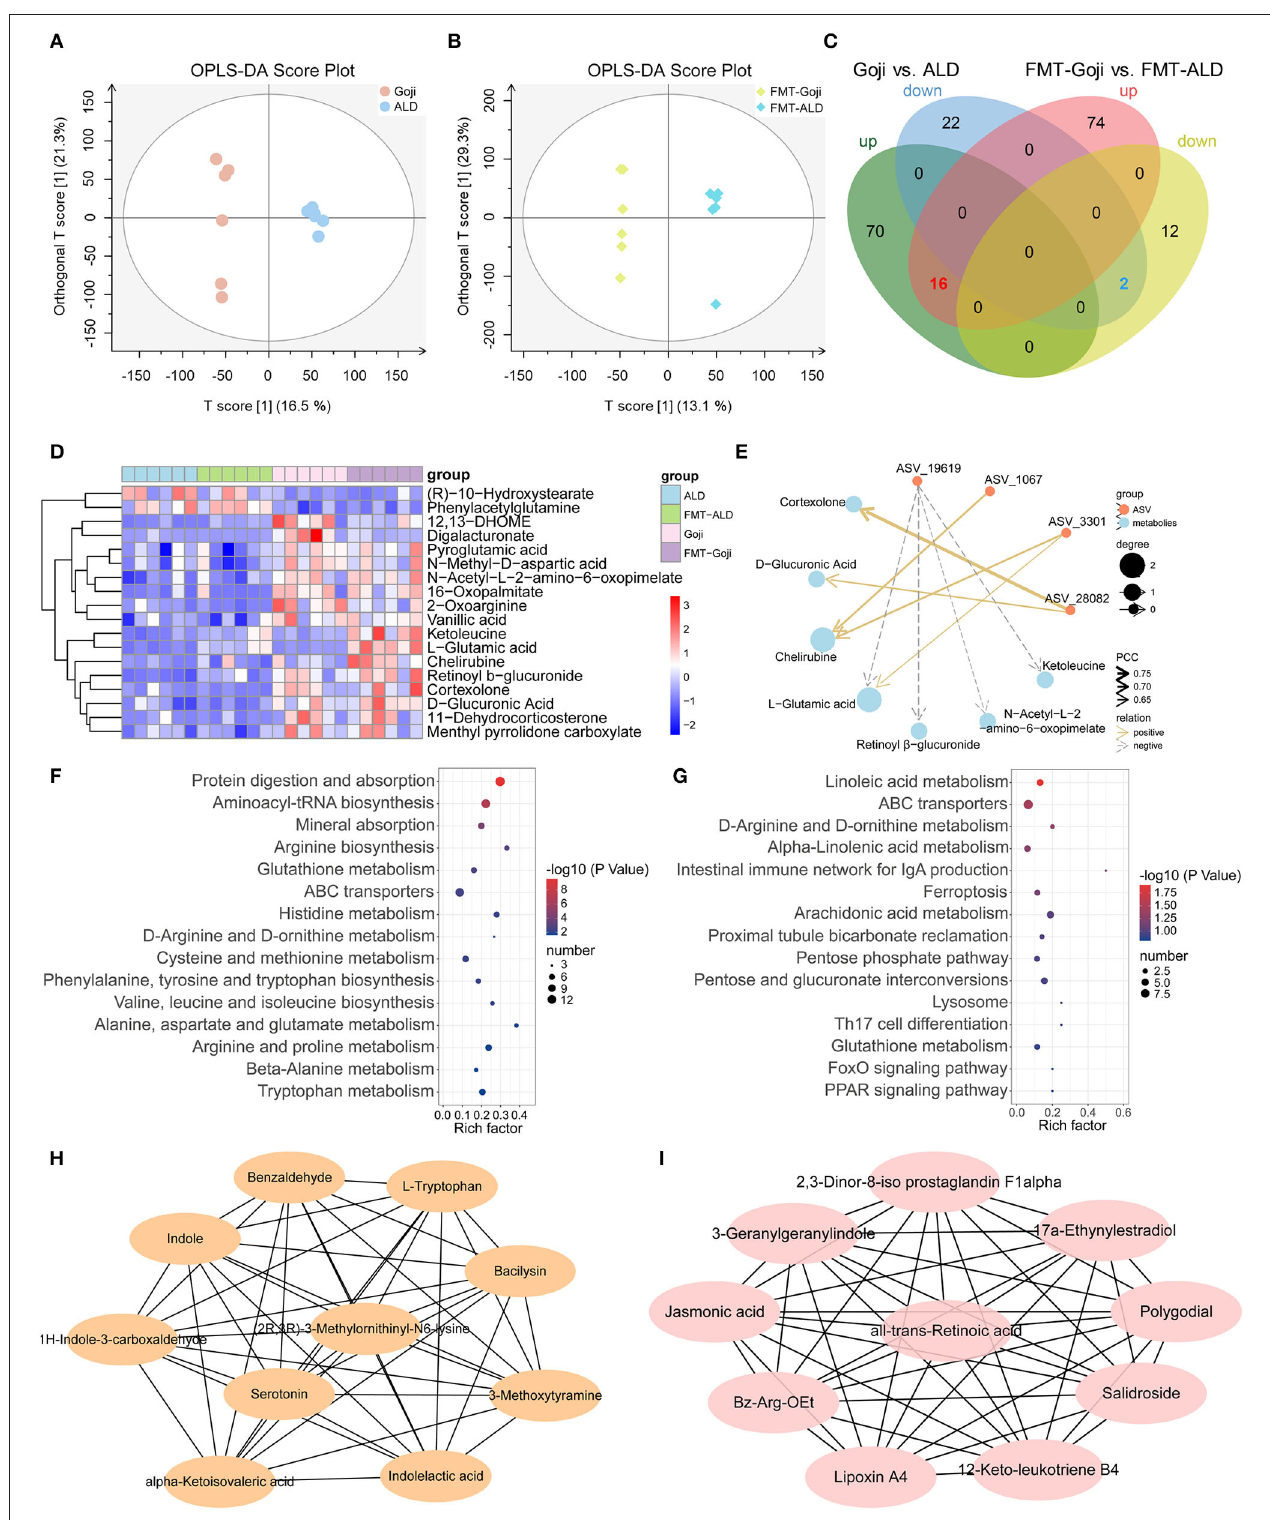
FIGURE 5 | Metabolic patterns in Goji vs. ALD and FMT-Goji vs. FMT-ALD mice. (A) The orthogonal partial least-squares discriminant analysis (OPLS-DA) of Goji vs. ALD. (B) OPLS-DA of FMT-Goji vs. FMT-ALD. (C) Venn diagrams of differential metabolites between Goji vs. ALD, and FMT-Goji vs. FMT-ALD. (D) heatmap of 16 upregulated and 2 downregulated metabolites in Goji and FMT-Goji group compared with ALD and FMT-ALD groups. (E) correlation network of metabolites and ASV. (F) KEGG enrichment pathways based on the differential metabolites in Goji vs. ALD. (G) KEGG enrichment pathways based on the differential metabolites in FMT-Goji vs. FMT-ALD. (H) the 10 metabolites in hub-network of DEMs between Goji and ALD. (I) the 10 metabolites in hub-network of DEMs between Goji and ALD.